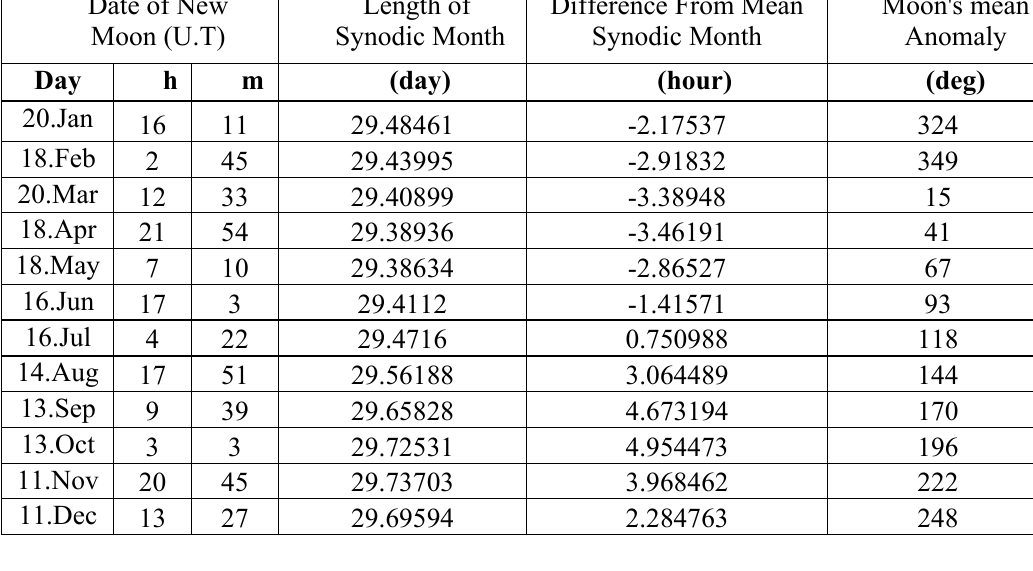
Table 1: Synodic month length in 2015 (sample of results through 100 years).